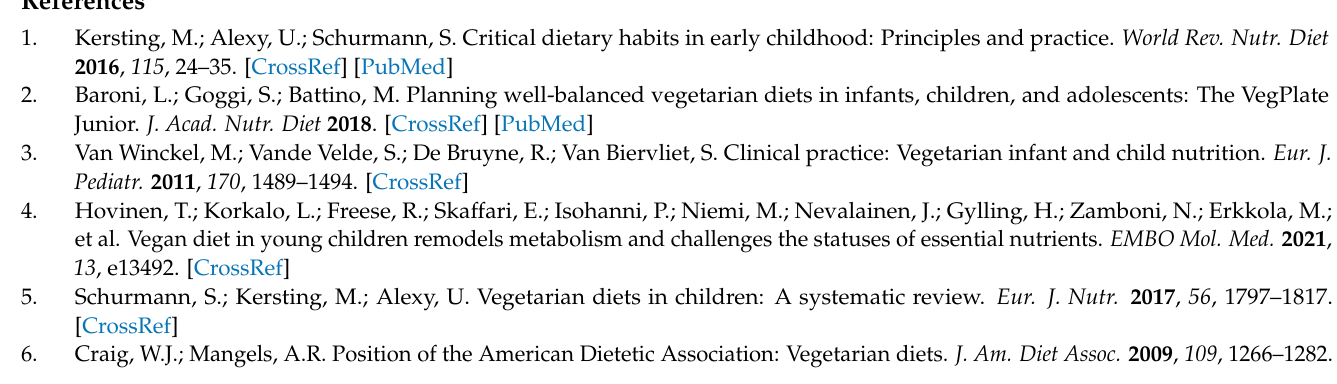
Table S2. Multivariate generalized linear model of irisin in the combined group of vegetarians and omnivores with main effect and 2-way interaction with the diet